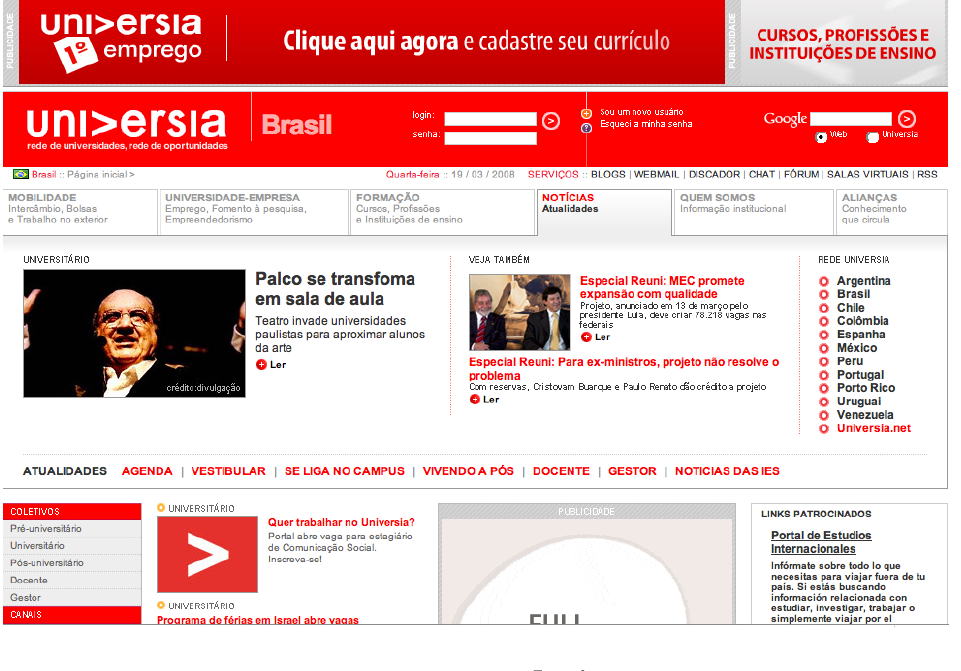
Figure 6. Snapshot of the Universia (Brazil) main